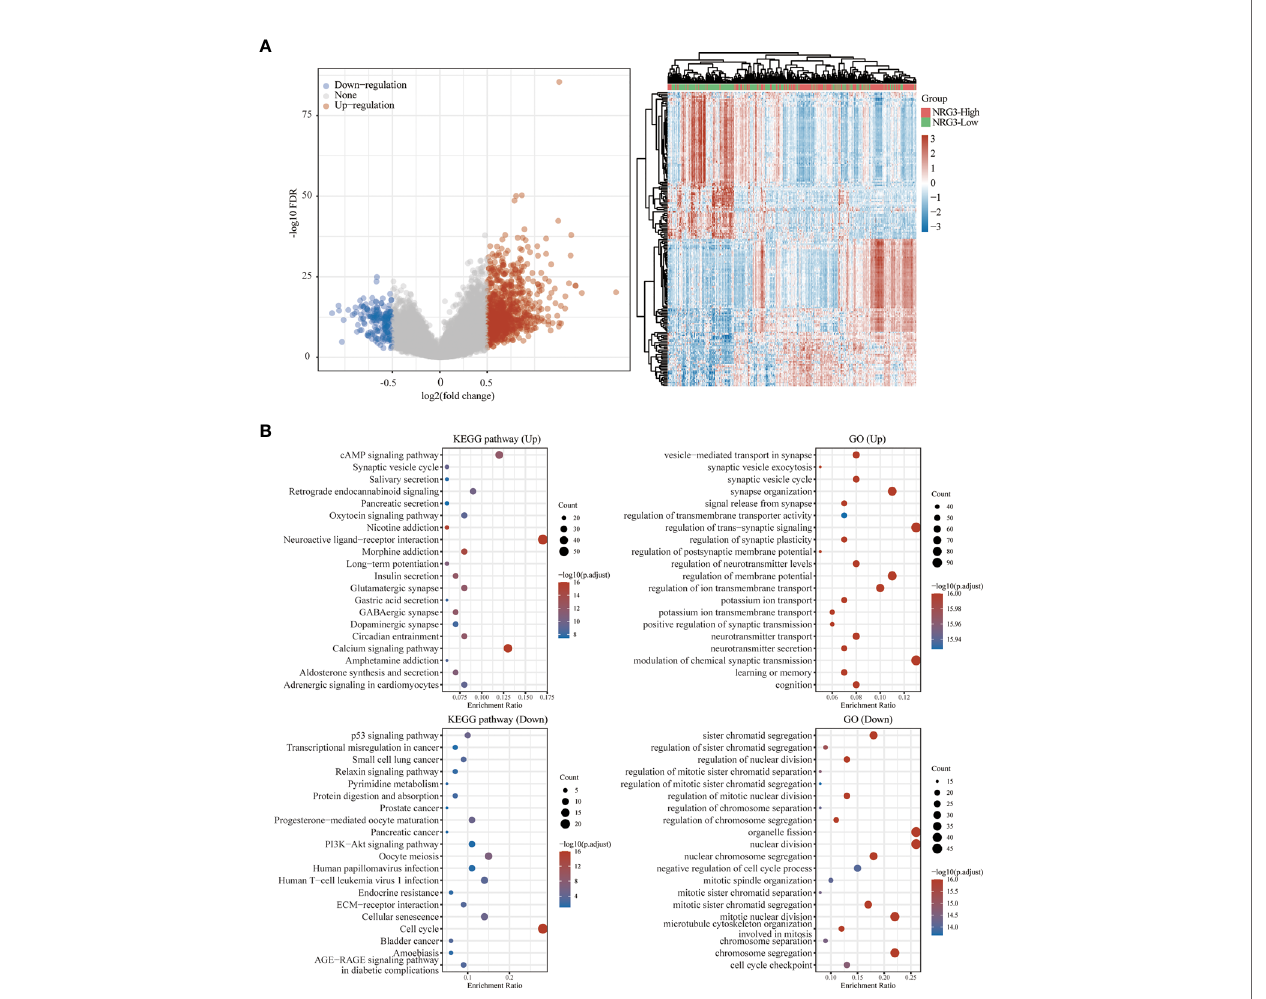
FIGURE 12 | Functional enrichment for gene set associated with high/low expression of NRG3 in patients with LGG. Differentially expressed genes for high expression of NRG3 vs low expression of NRG3 in LGG were shown in the volcano plot (A) , with blue dots representing signi fi cantly down-regulated genes and orange dots representing signi fi cantly up-regulated genes in high expression of NRG3 in LGG, and heatmap exhibits the expression level. Enrichment analysis for KEGG pathway and GO term of down-regulated genes and up-regulated genes in high expression of NRG3 in LGG (B)